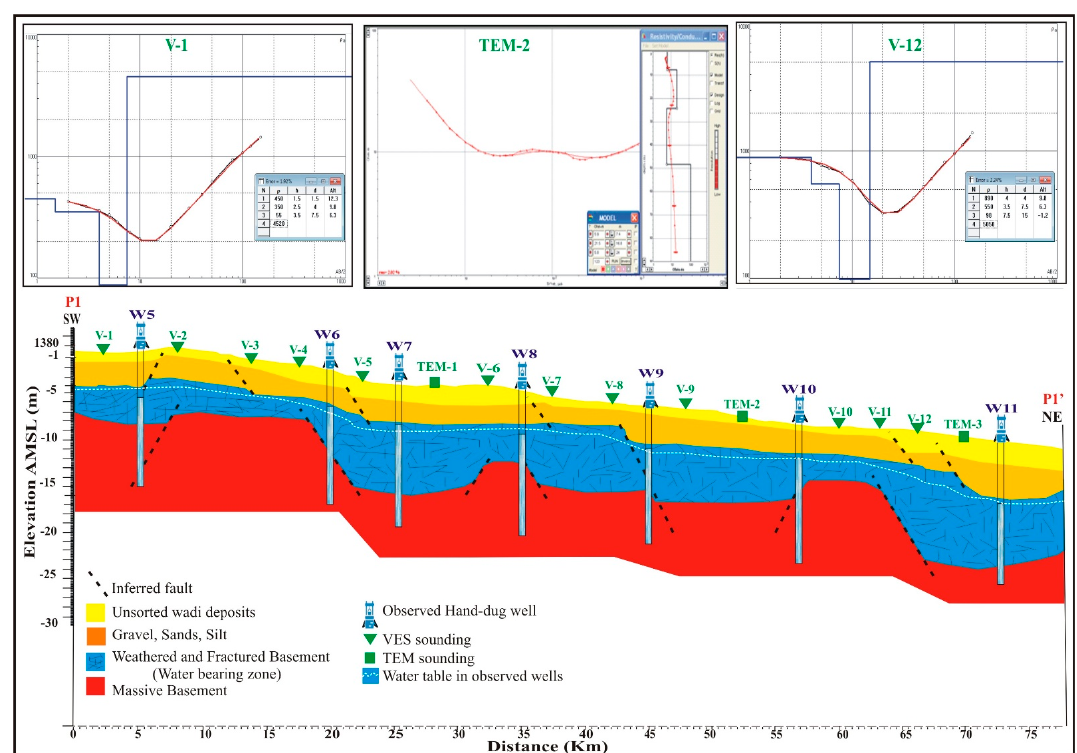
Figure 11. The geoelectric cross-section P1–P1’, with the sounding and the modeled data of VES (V-1, and V-12) and TEM-2.